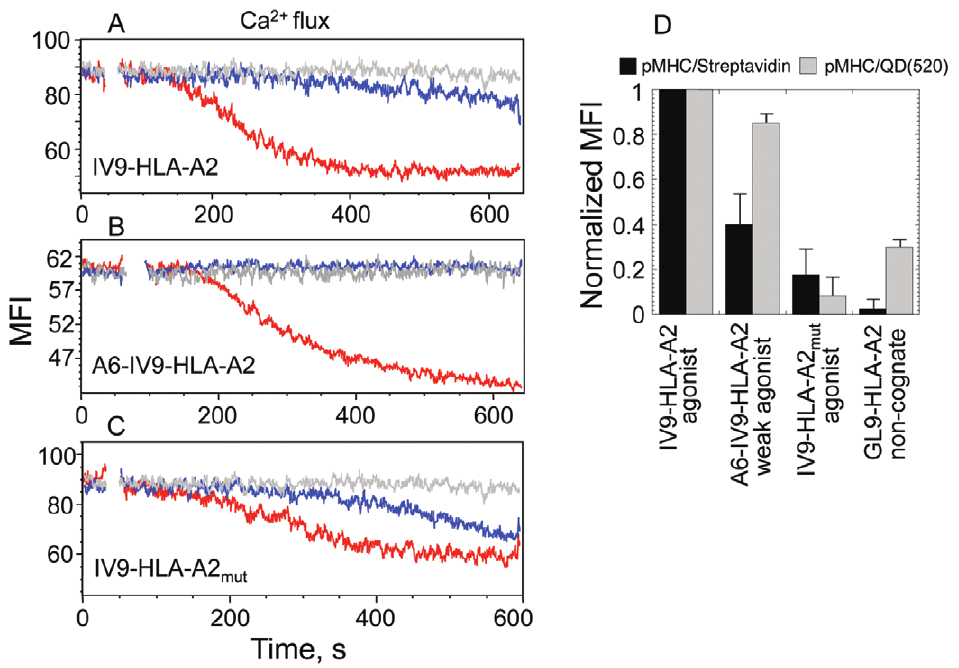
Figure 4. Difference in TCR-mediated signaling kinetics induced by pMHC/QD and pMHC/Streptavidin oligomers. A , B , C. Time- dependent changes in intracellular calcium concentration in CD8 + 68A62 CTL induced by indicated pHLA-A2 ligands assembled on either QD(520) (red) and Streptavidin (blue) scaffolds. Concentration of the probes in extracellular medium was the following: 1 nM for IV9-HLA-A2/QD(520) and IV9- HLA-A2/Streptavidin ( A ), 10 nM for A6-IV9-HLA-A2/QD(520) and A6-IV9-HLA-A2/Streptavidin ( B ), 5 nM for IV9-HLA-A2 mut /QD(520) and IV9-HLA- A2 mut /Streptavidin ( C ). Representative results are shown. D. Relative equilibrium binding of indicated pHLA-A2 ligands assembled on either QD(520) and Streptavidin scaffolds to 62A68 CD8 + CTL is shown. The relative amounts of cell-bound ligands were calculated from MFI measured by flow cytometry. Data represent mean 6 s.d.